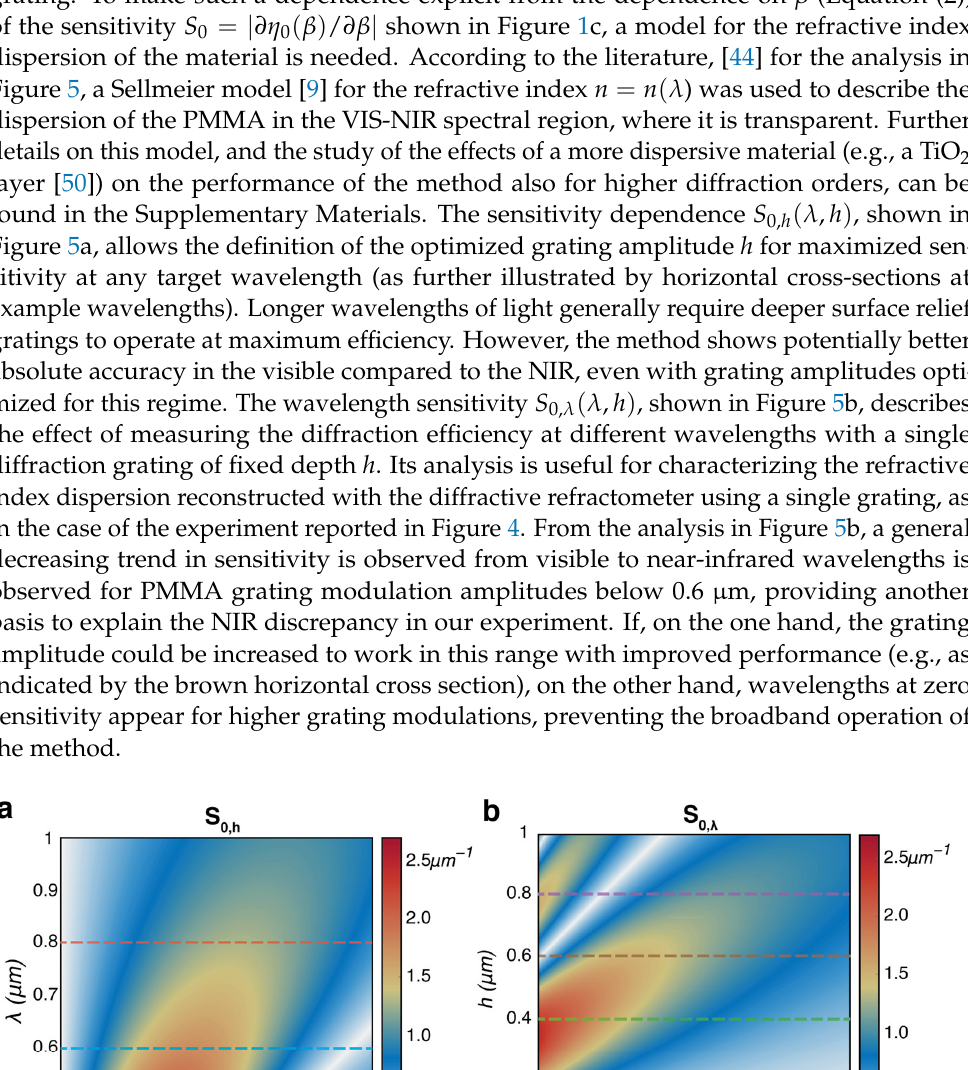
11 of 15 Figure 4. Measurement of the PMMA refractive index dispersion at discrete wavelengths using the